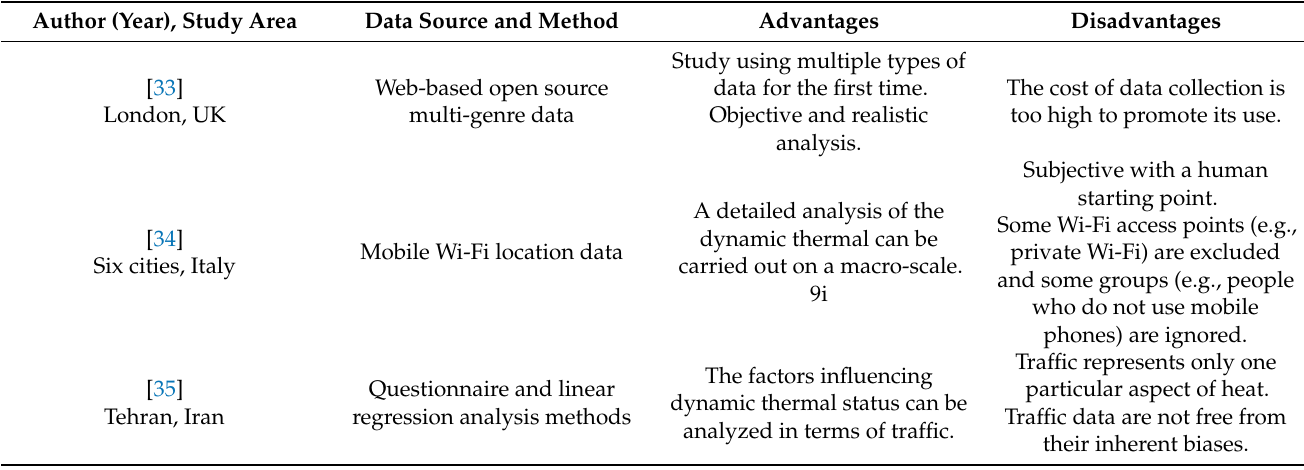
Figure 1. Analysis approach. Table 1. Commonly used methods of measuring the dynamic thermal